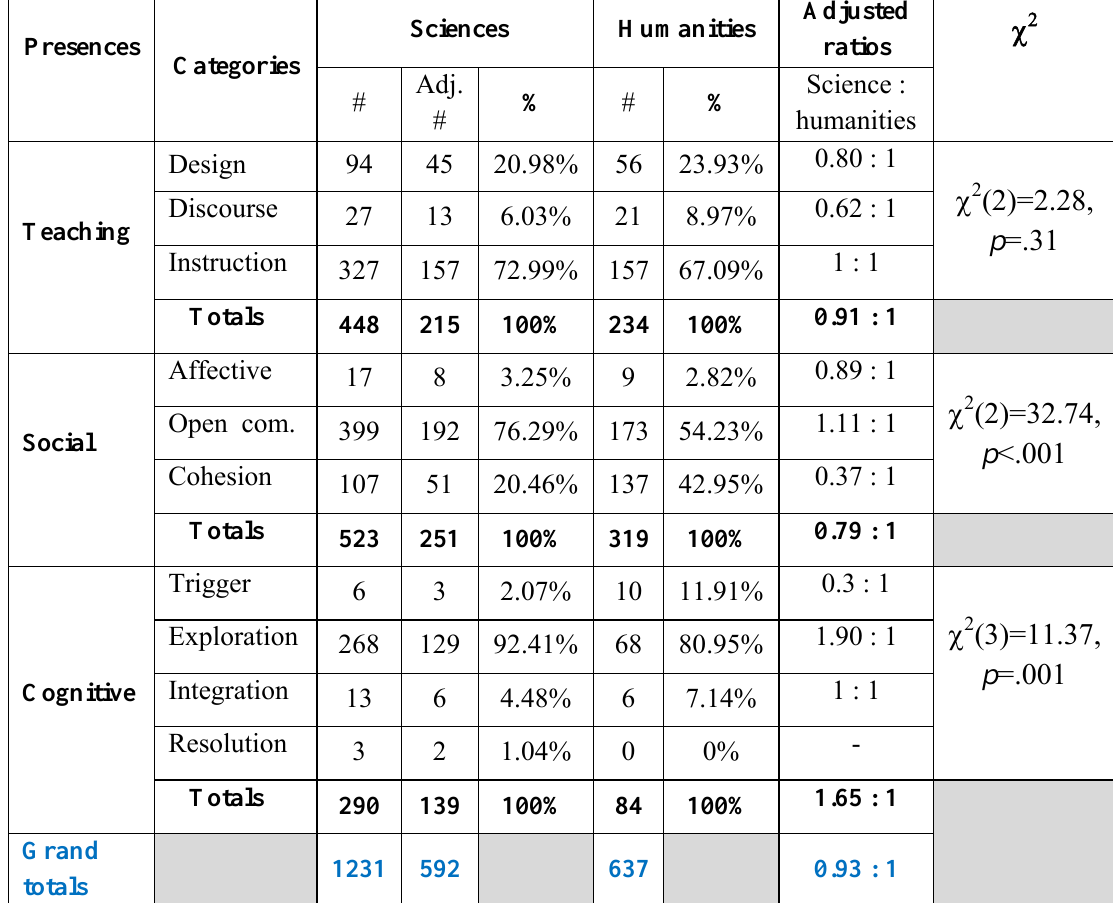
Table 8 Teaching, Social, and Cognitive Presence by Categories: Instructors Only